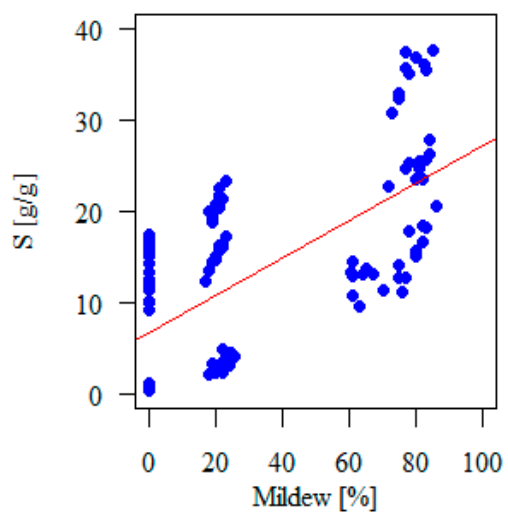
Figure 5. A diagram of dependency between S (canopy water storage capacity) and mildew ( Microsphaera alphitoides Griff. et Maubl).